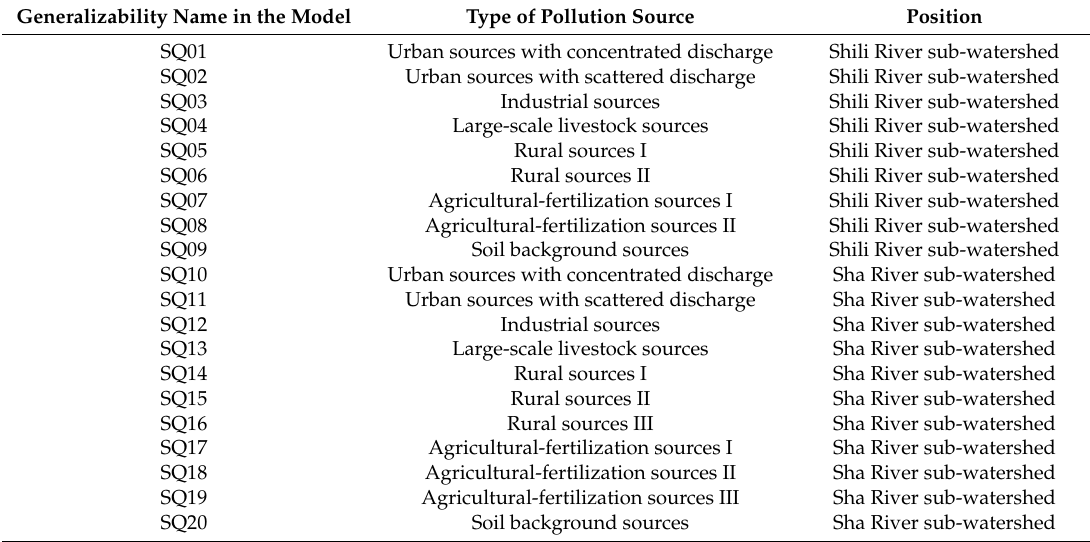
Table 1. Information of the 20 sub-watershed pollution